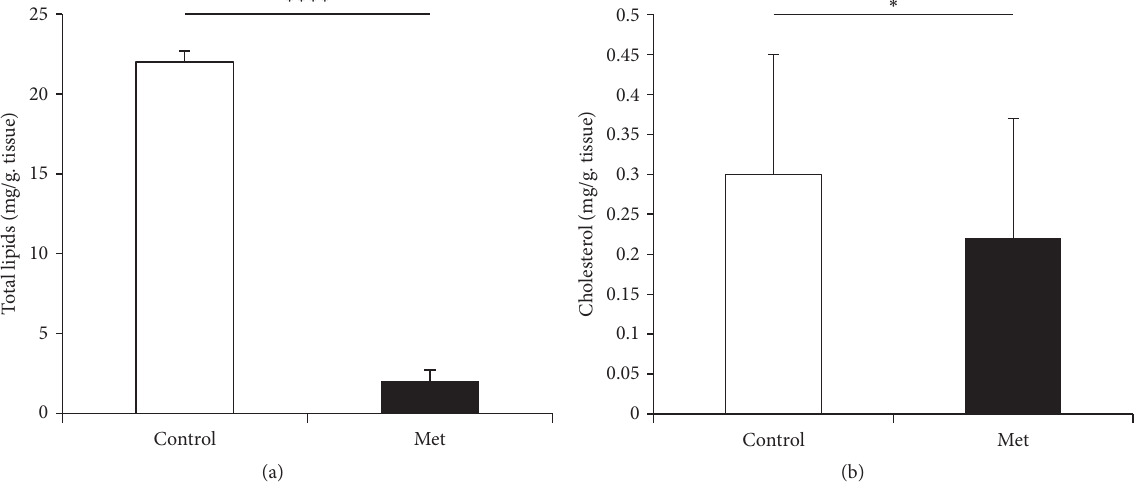
Figure 10: Aorta total lipids and cholesterol of newborn rabbit. Control: offspring from control female rabbit (PC); Met: offspring from female rabbit fed Met enriched diet (PMet) ( ∗ 𝑝 < 0.05 , ∗∗∗∗ 𝑝 < 0.0001 ).